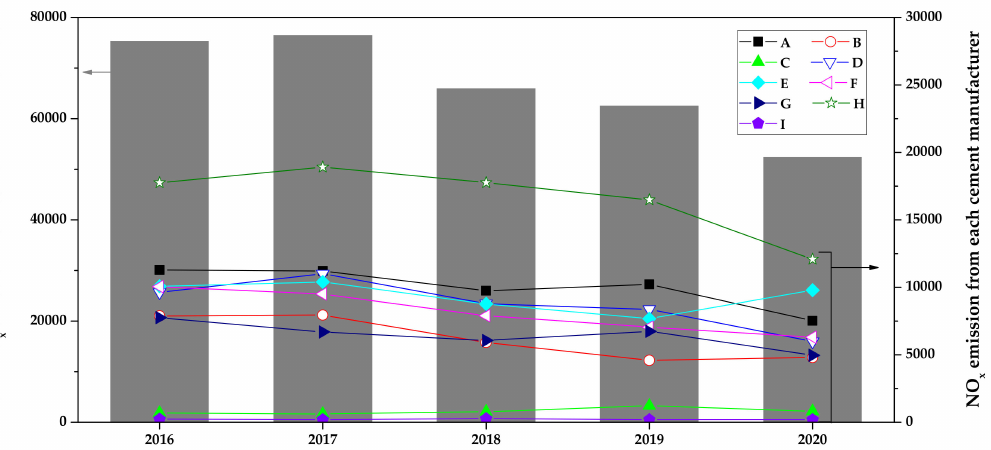
Figure 6. NO x emissions of Korean cement manufacturers for the period 2016–2020 (Units: tons/year) (data taken from [15]).